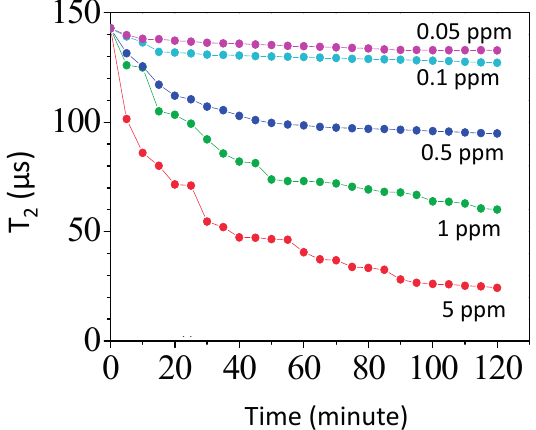
Figure 5. Time-dependent T 2 of protons in assaying different amount of